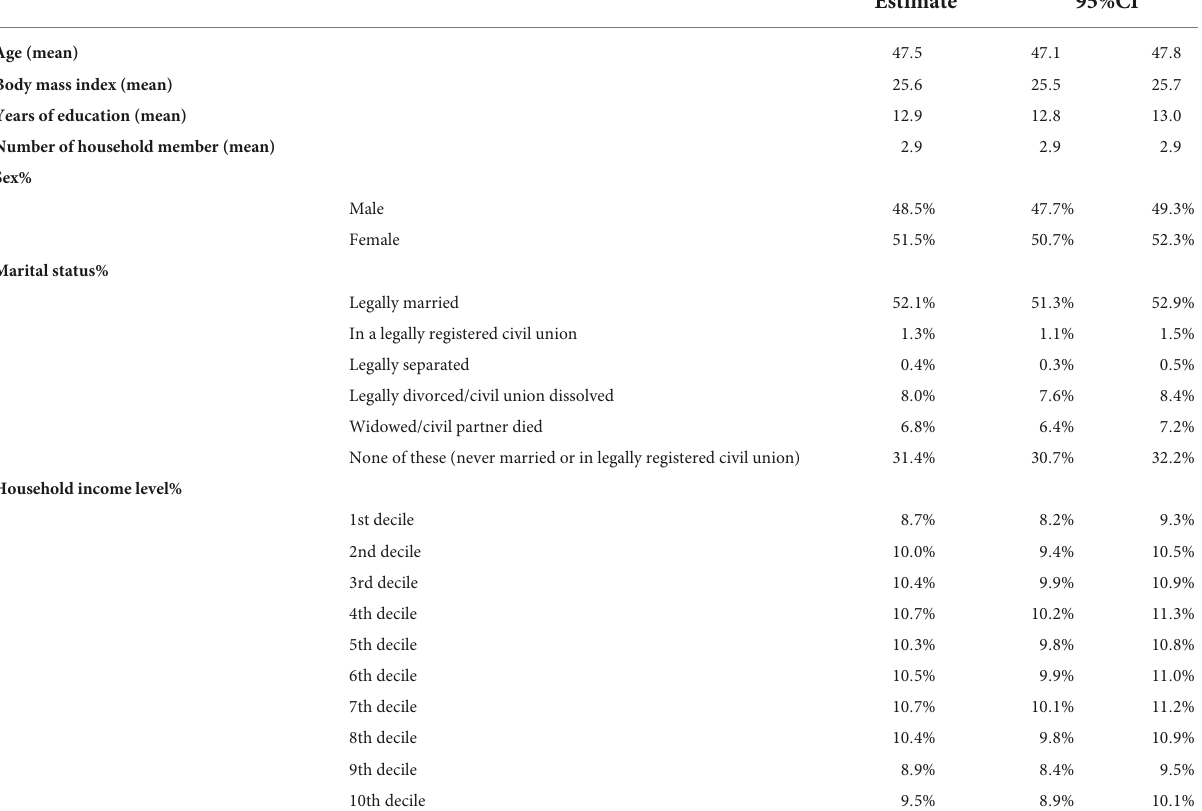
TABLE 1 Sample characteristics of this